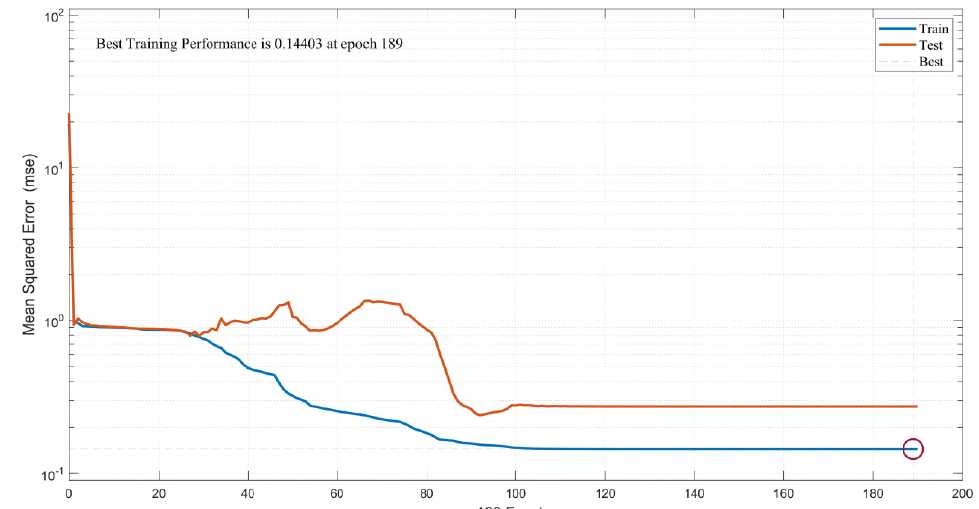
Figure 9. BR model